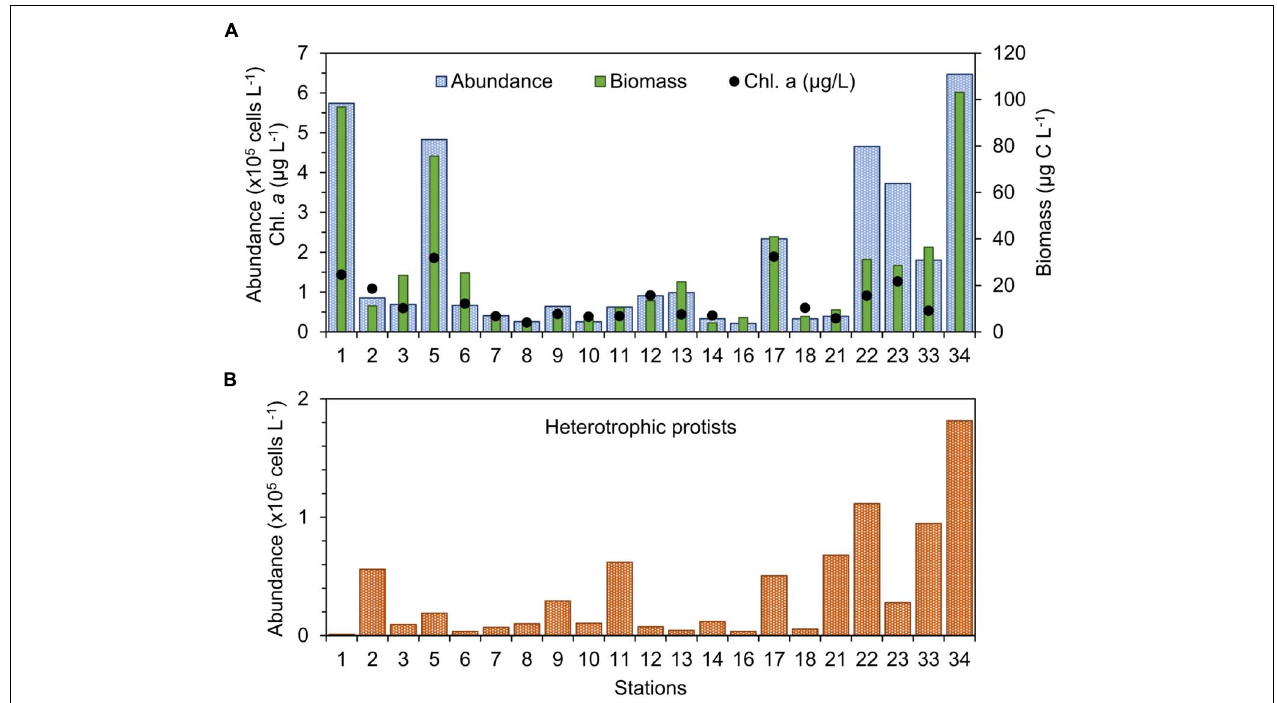
FIGURE 3 | (A) Abundance, biomass, and chlorophyll a concentration of phytoplankton and (B) abundance of heterotrophic protists in the study stations in September 2015.